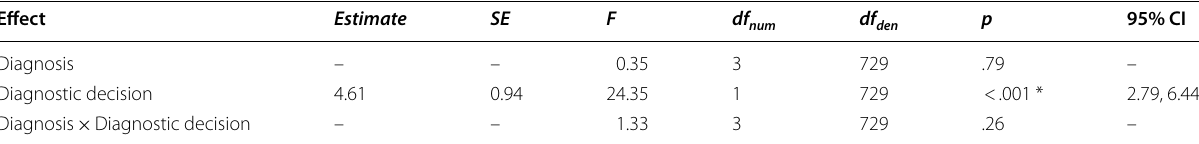
Each effect was entered as a fixed effect in a multilevel linear model, along with a random intercept for participant. Type III F tests with Kenward-Roger estimations for degrees of freedom are reported. An asterisk (*) denotes p < .05